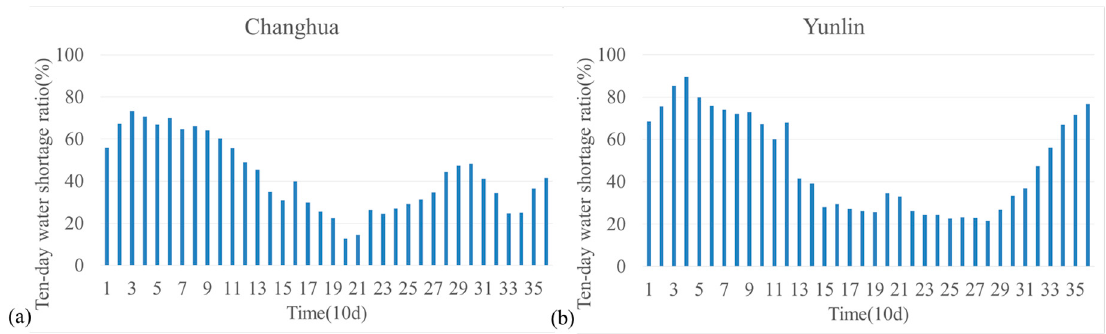
Figure 5. Water shortage ratio (R) in Changhua ( a ) and Yunlin ( b ) for agricultural water use. Table 4. Analysis of water shortage of Formosa Plastics Corporation (FPC) under baseline.